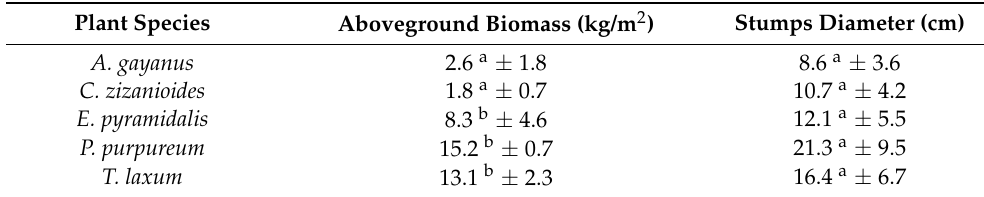
Table 2. Mean and standard deviation of plant aboveground biomass and stump diameter of the different plant species in the pilot VFCW beds. Values within the same column followed by the same superscript letter (i.e., a, b) are not statistically significantly different at p <